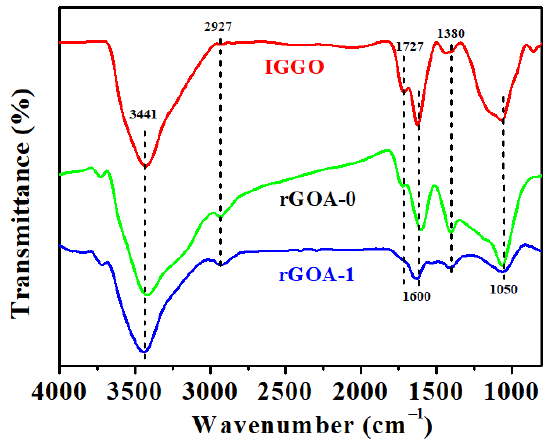
Figure 5. Fourier-transform infrared (FTIR) spectra of IGGO, rGOA-0, and rGOA-1.